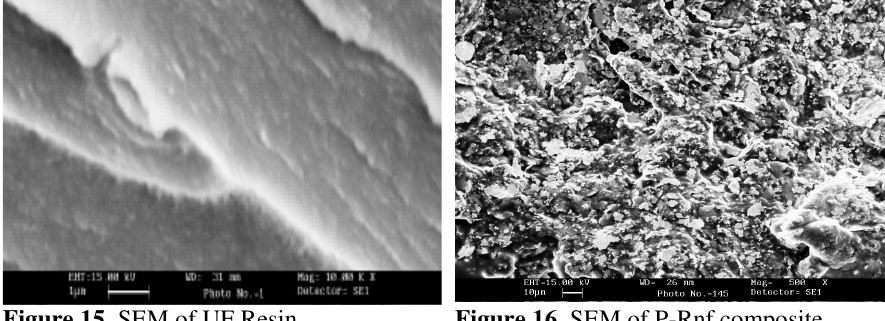
Figure 15. SEM of UF Resin Figure 16. SEM of P-Rnf composite